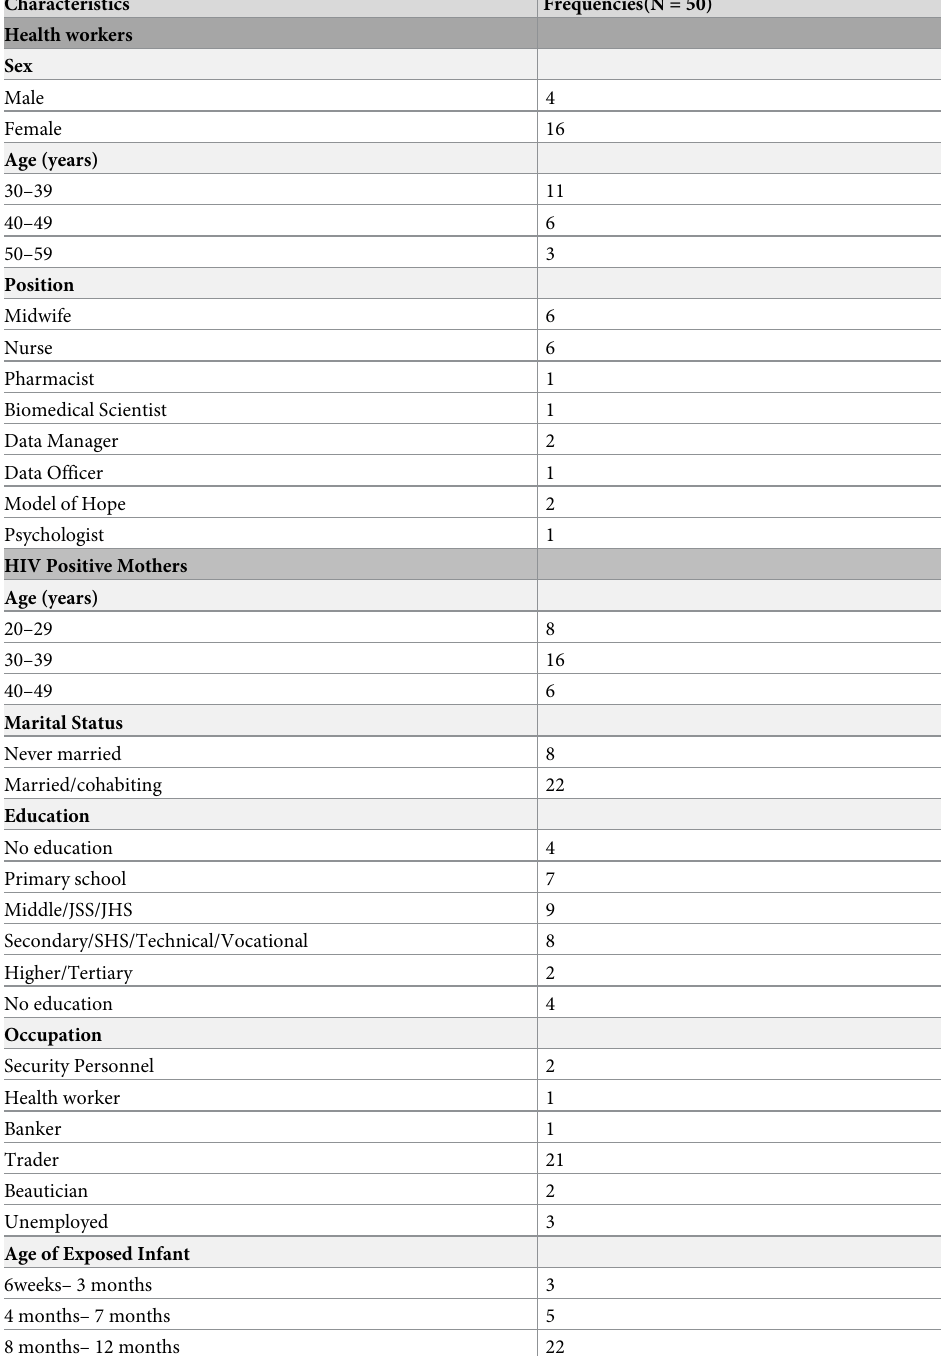
Table 1. Socio-demographic characteristics of study participants.